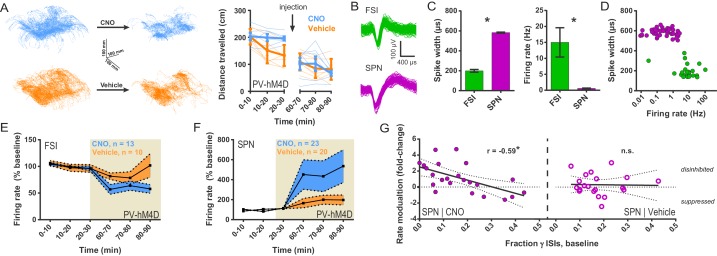
Chemogenetic inhibition of FSIs in DLS exerts a strongly disinhibitory net effect and selective excitatory effect on striatal output.(A) Locomotion before and after CNO or vehicle administration. Left: Example 3D traces showing head position during 30 min recordings before and after i.p. injection of CNO (blue) or vehicle (orange). Right: group-wise quantification of distance travelled shows that CNO- and vehicle-treated subjects did not respond differently to i.p. injections (p=0.16 for interaction of time and treatment, n = 6 and 7 mice). Subjects non-specifically decreased locomotor activity following the i.p. injection procedure (F(11,1) = 49.01, p=2.27×10−5, n = 6 and 7 mice). (B) Representative single-unit waveforms classified as FSIs (top, green) and SPNs (bottom, purple). (C) Waveform properties used for cell type classification. Left: FSI waveforms display a shorter spike width relative to those of SPNs (t(64) = 30.67, p=5.53×10−40, n = 23 FSIs and 43 SPNs). Right: FSIs display higher firing rates than SPNs (t(64) = 4.32, p=0.000056, n = 23 FSIs and 43 SPNs). (D) Classification of single units as FSIs (green) or SPNs (purple) by spike width and firing rate. (E) Time course showing FSI firing rates before (white background) and after (tan background) i.p. injection of CNO (blue) or vehicle (orange). CNO injection decreased FSI firing rate relative to vehicle (interaction between drug and time: F(5,105) = 2.51, p=0.034, n = 13 and 10 FSIs). (F) SPN responses to CNO or vehicle as in (E). CNO injection increased SPN firing rate relative to vehicle (interaction between drug and time: F(5,205) = 2.63, p=0.025, n = 23 and 20 SPNs). (G) Linear regression of fold-change (log2 post/pre) in firing rate after CNO (left) or vehicle (right) injection against the baseline fraction of ISIs in the gamma frequency band. SPNs with higher fractions of gamma-frequency ISIs at baseline are more likely to decrease firing rate when FSIs are inhibited with CNO (r(22) = −0.59, p=0.0032, n = 23 cells) whereas vehicle caused no change in firing rate that could be predicted by baseline fraction of gamma ISIs (p=0.92, n = 20 cells). *p<0.05. Data are represented as mean ± SEM. Example units before and after CNO shown in Figure 5—figure supplement 1.